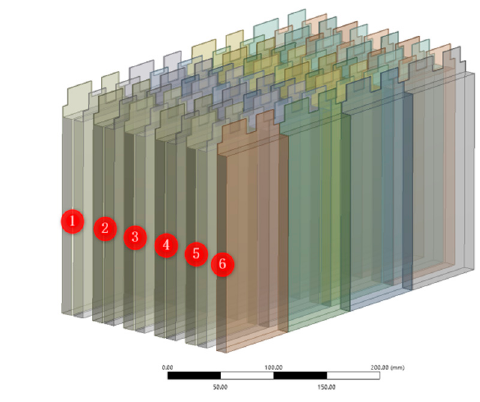
Figure 1. Simplified 3D model of a power battery pack.